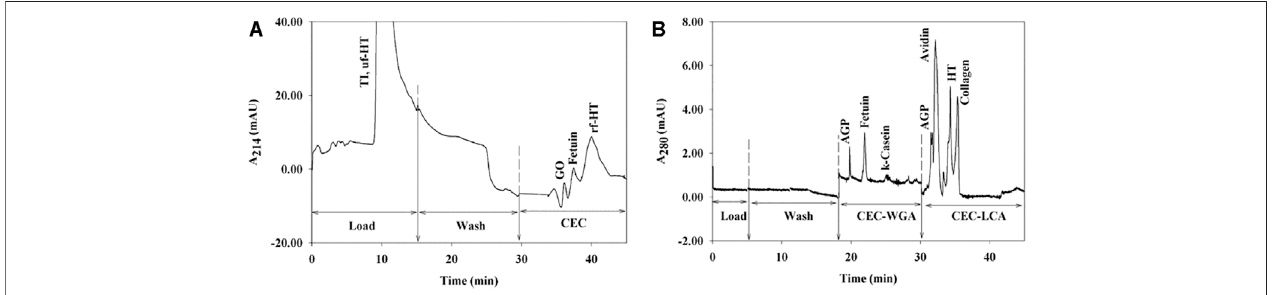
FIGURE 4 | Electrochromatogram of (A) GO, fetuin, and HT in the presence of nonglycosylated TI, obtained on WGA immobilized on a monolithic column by a three-step process and of (B) AGP, HT, collagen, k-casein, avidin, and fetuin, obtained on coupled monolithic lectin columns (order WGA → LCA). HT: